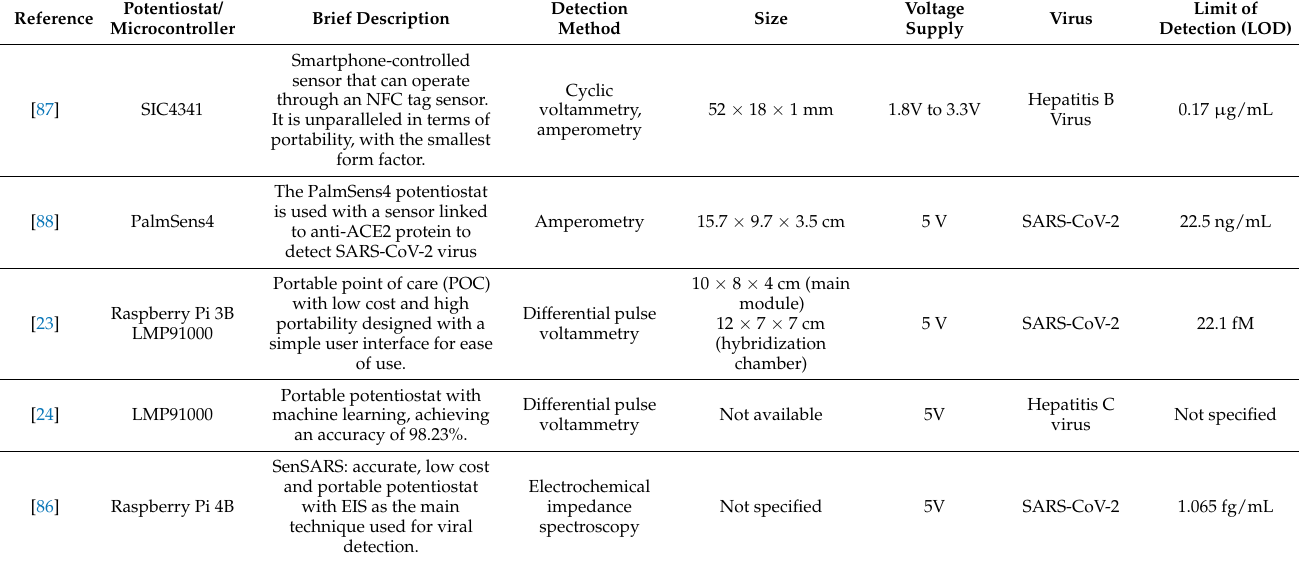
Table 3. Comparison of portable potentiostats used for virus